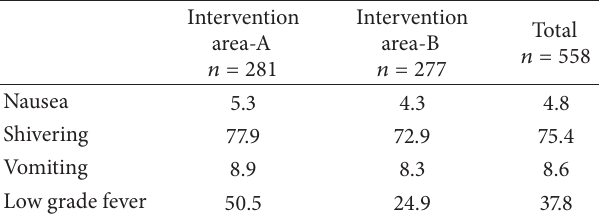
Figure 1: Distribution and consumption of misoprostol tablets for prevention of postpartum haemorrhage in intervention and control areas. Table 4: Side effect experienced by mothers who took